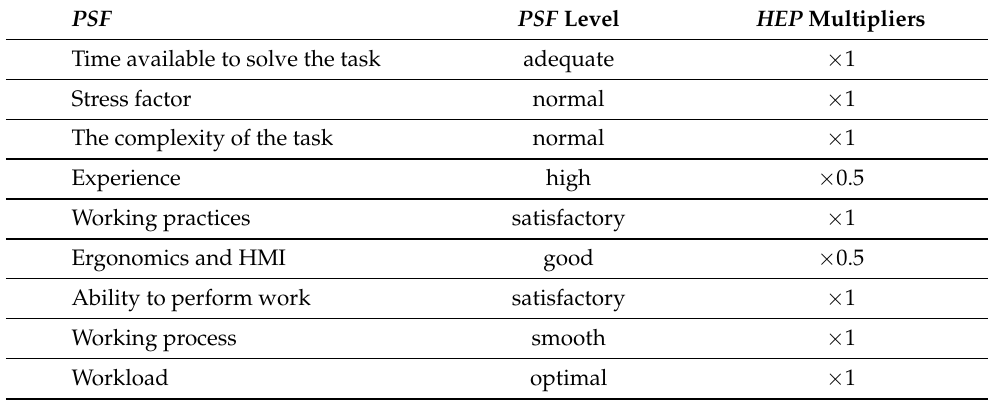
Table 5. PSF s overview for workplace A.